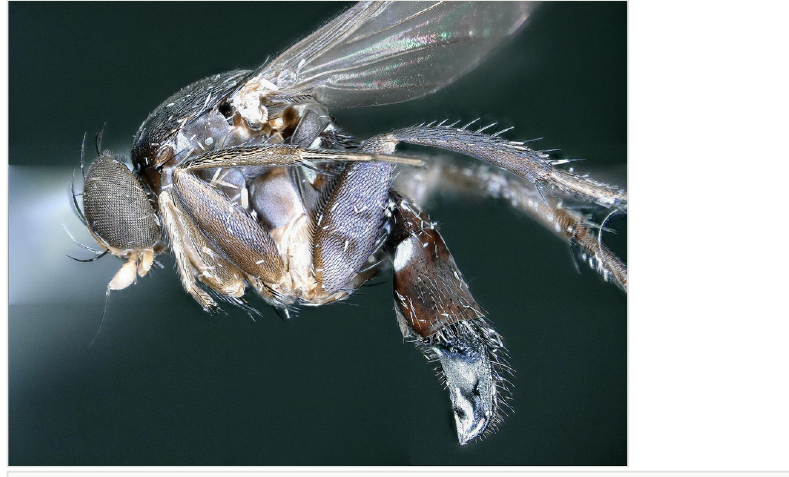
Habitus, left lateral, of Melaloncha ( Udamochiras ) nielsi sp.